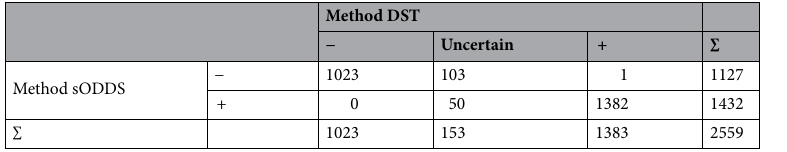
Table 2. Receptor status due to decision theory (DST) compared with previous method (ODDS). 2559 Patients have been assessed for hormone receptor status by method sODDS to comprise the input dataset. DST was then applied to this dataset. A sample was considered H + if at least one receptor was positive. Difference between methods sODDS and DST is reflected in Cohen’s κ = 0.88. Note that uncertain results were considered as separate category in computing κ.